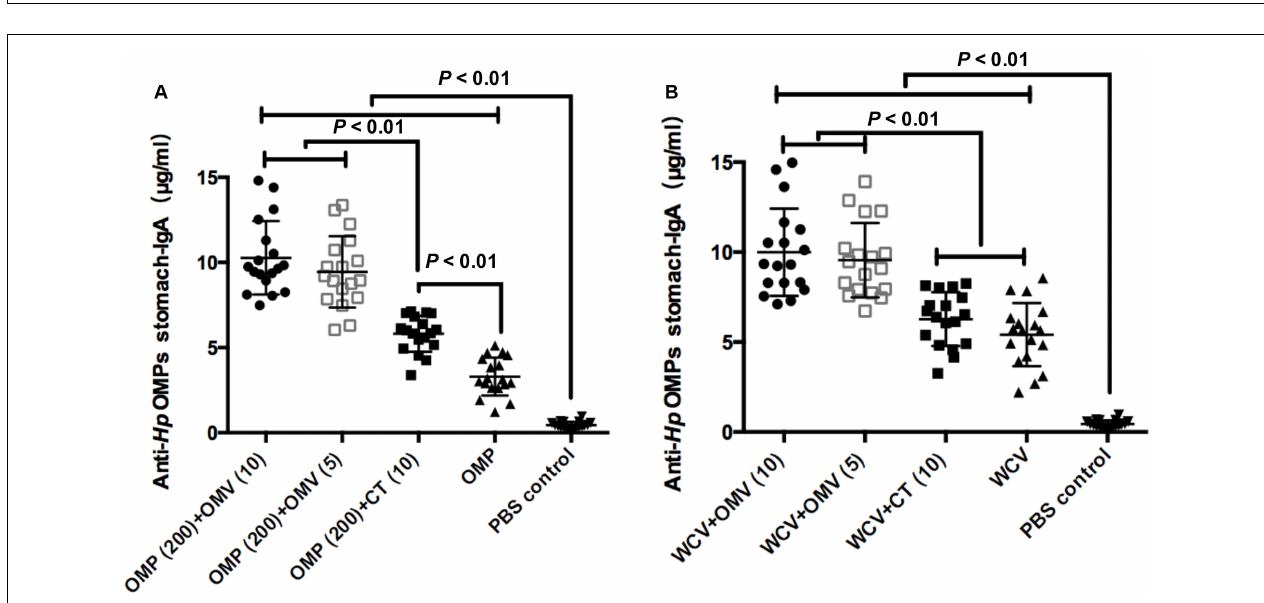
FIGURE 4 | Concentrations of anti- Hp OMP stomach-IgA using OMP as vaccine (A) or WCV (B) from the stomach of mice sacrificed were determined quantificationally by ELISA at week 8. Each group was comprised of 18 mice. These data manifested the strength of mucosal immune response induced by diverse immunogens, which were expressed as means ± SD per group. Least significant difference test was performed to determine whether the distinction between each mean of groups were significant. P < 0.01 represents the difference between the related groups.